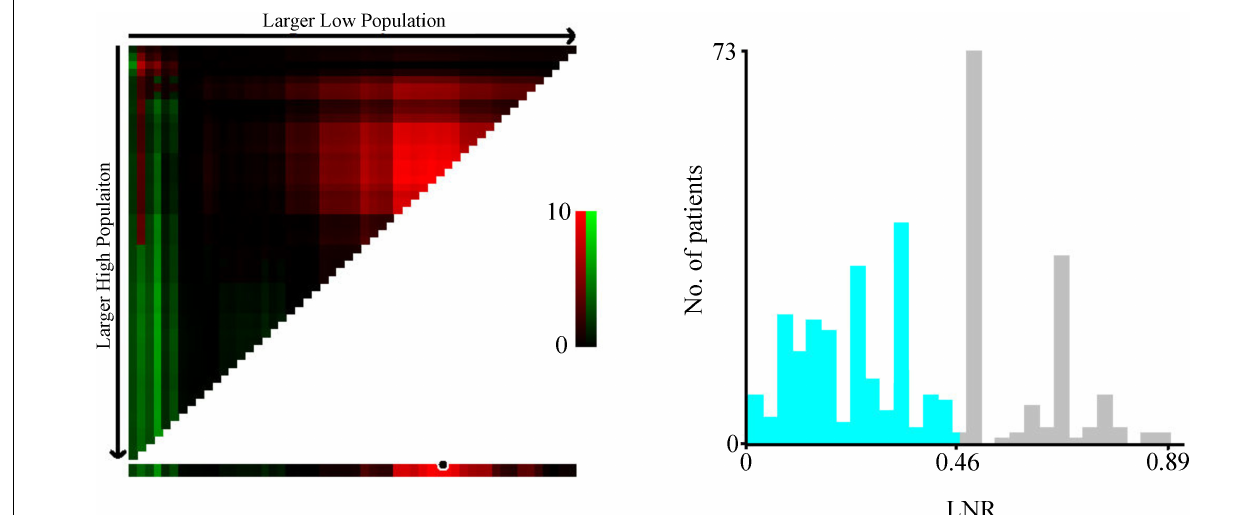
FIGURE 1 | Optimal cutoff value produced by X-tile software.